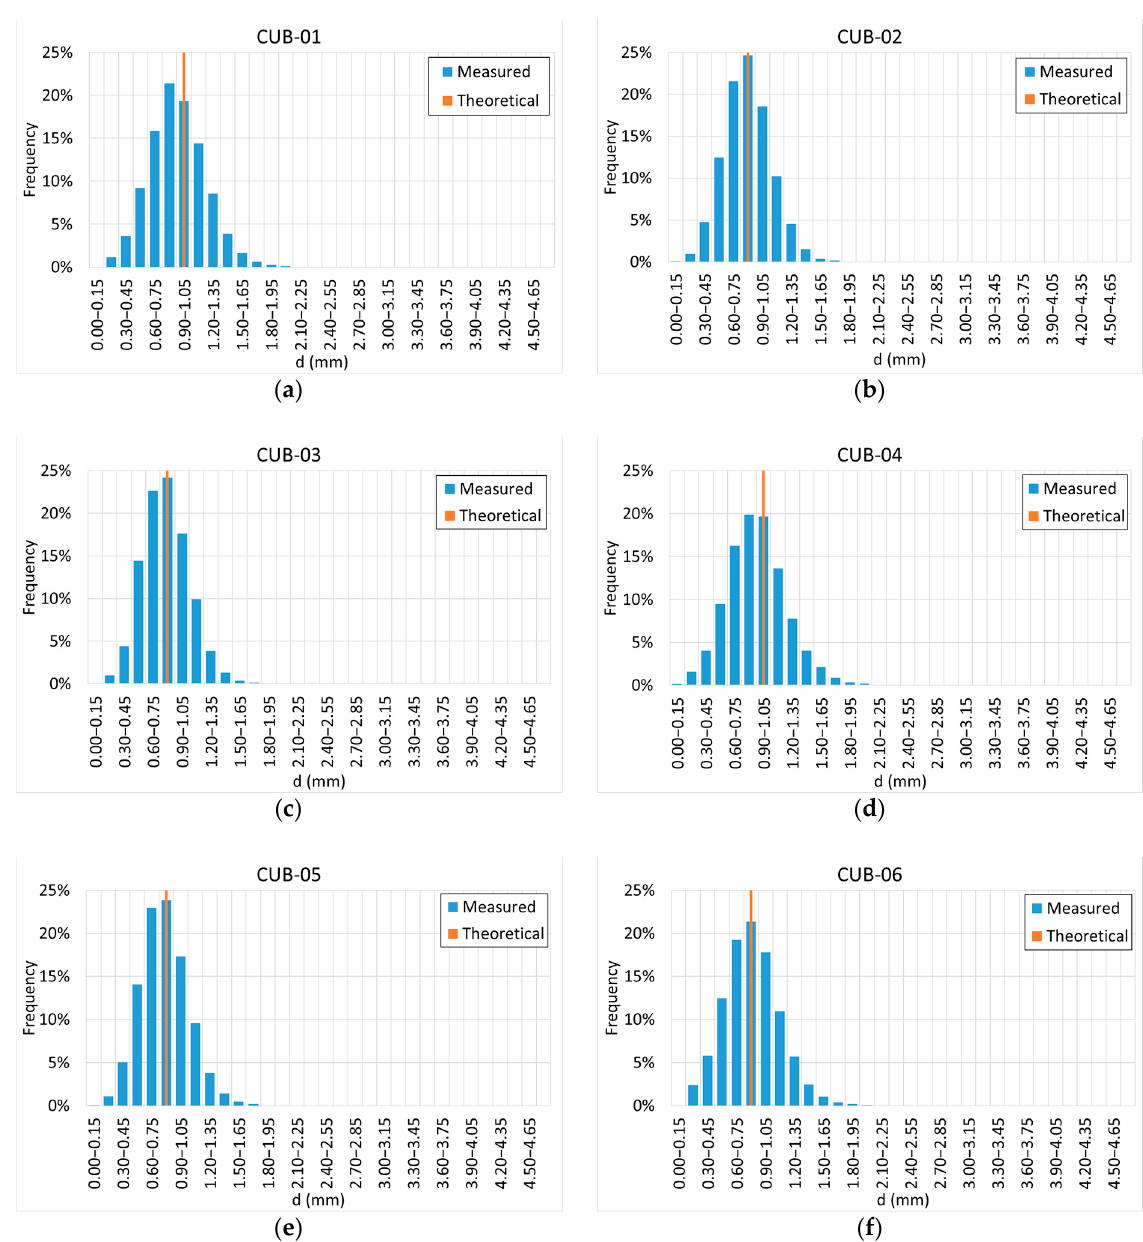
Figure 16. Neighborhood test. Comparison between real and theoretical histograms. From ( a – f ) specimens 1 to 6.